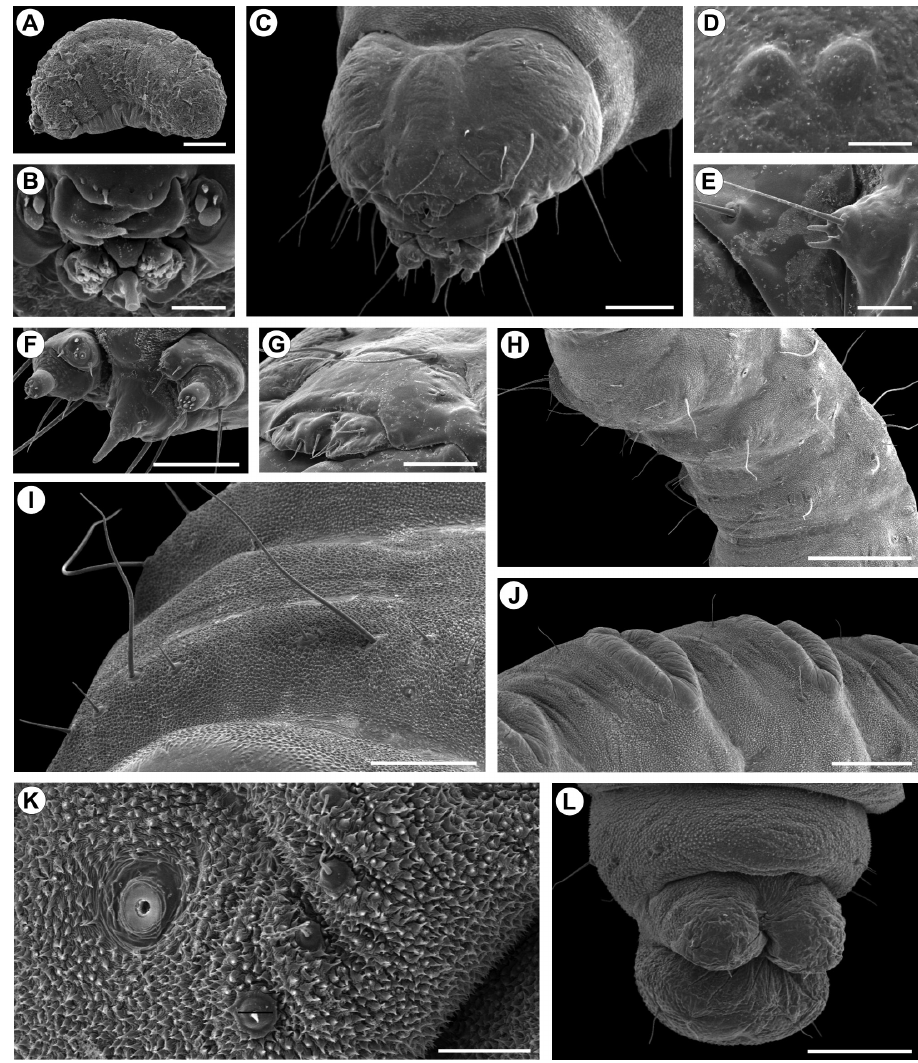
Figure 6. Morphology of C. pampeanus first (A, B) and last (C-L) larval instars under scanning electron microscopy. A general aspect, lateral view; B, buccal apparatus, anterior C , head, latero-dorsal D stem- mata, lateral; E , left antenna, lateral F maxilla and labium, antero-lateral G labrum and clypeus, latero- dorsal H thorax, latero-ventral I meso- and metathorax in detail, with aligned setae of different lengths, antero-dorsal J second and third abdominal segments, showing tergal calli, latero-dorsal K eight abdomi- nal segment in detail, showing aligned secondary setae (arrows) and spiracle, lateral L last abdominal segments, ventral. Scale bars: 100 µm ( A, F, G ); 10 µm ( B ); 200 µm ( C ); 50 µm ( D, E, K ); 250 µm ( J ); 1 mm ( H, L ); 0.5 mm ( I